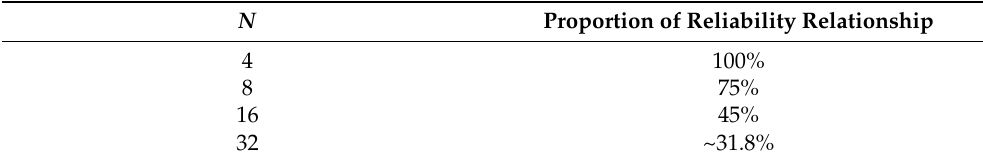
Table 1. Reliability ratio of subchannels.